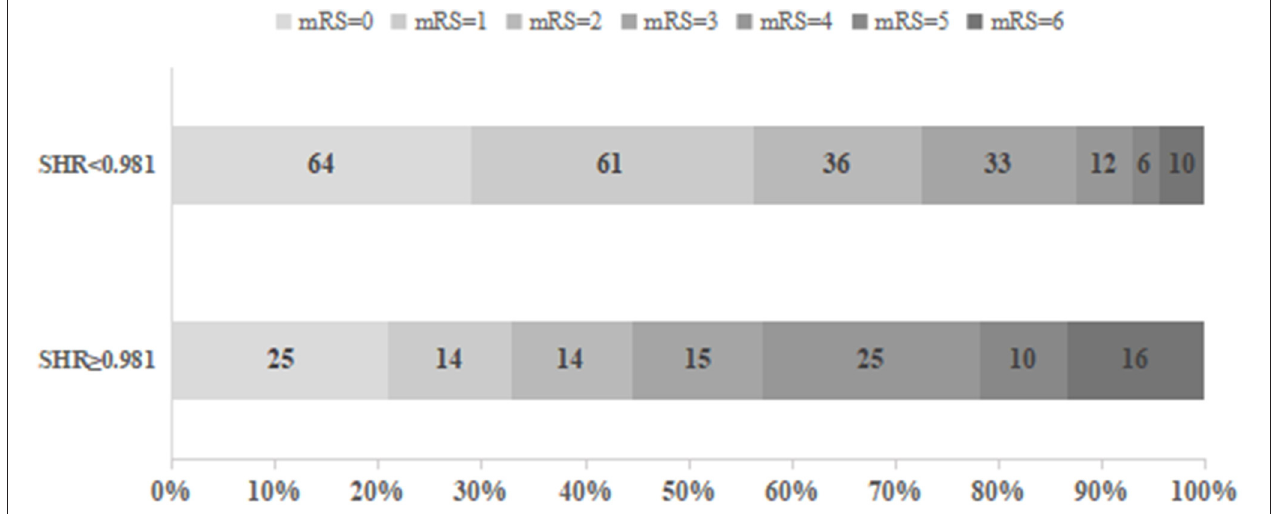
FIGURE 2 | Functional outcomes at 3 months in groups stratified according to the cutoff value of